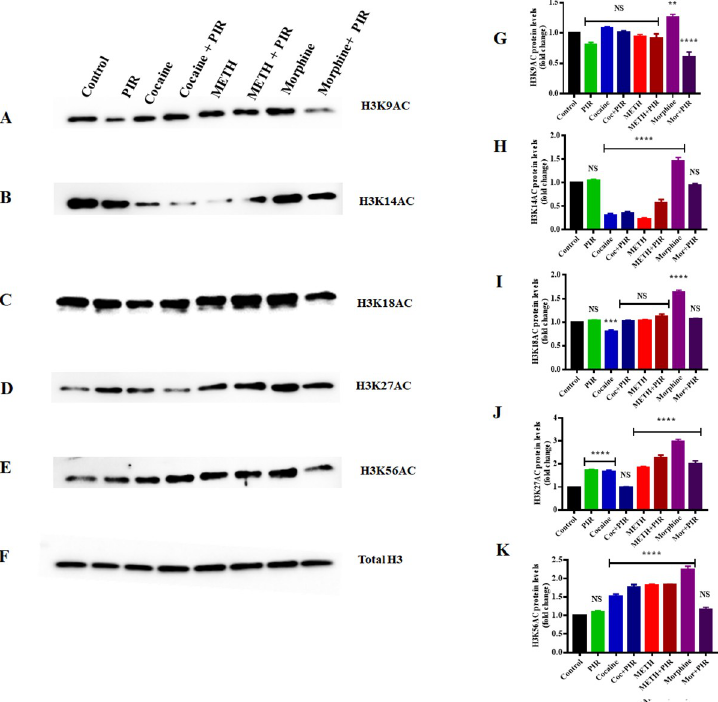
Fig 4. Effects of the psychostimulants cocaine, METH and morphine on H3 histone proteins in human primary astrocytes. Cells were exposed to cocaine (1 μ M), METH (10 μ M), and morphine (5 μ M) either alone or in combination with piracetam (10 μ M) for 24 h. The protein expression levels of H3K9AC, H3K14AC, H3K18AC, H3K27AC, and H3K56AC in astrocytes were determined by western blotting analysis using total H3 as a loading control. Two-way ANOVA analysis performed to compare the groups between cocaine Vs cocaine + piracetam, METH Vs METH + piracetam and morphine Vs morphine + piracetam. Western blot showing (A) H3K9AC, (B) H3K14AC, (C) H3K18AC, (D) H3K27AC, and (E) H3K56AC. The densitometric analysis results in G, H, I, J and K represent the protein levels (fold-change control) of H3K9AC, H3K14AC, H3K18AC, H3K27AC, and H3K56AC, respectively. The data are expressed as the mean ± standard error mean of three independent experiments. N = 3. ���� P < 0.0001, ��� P < 0.001, �� P < 0.01, NS—nonsignificant.